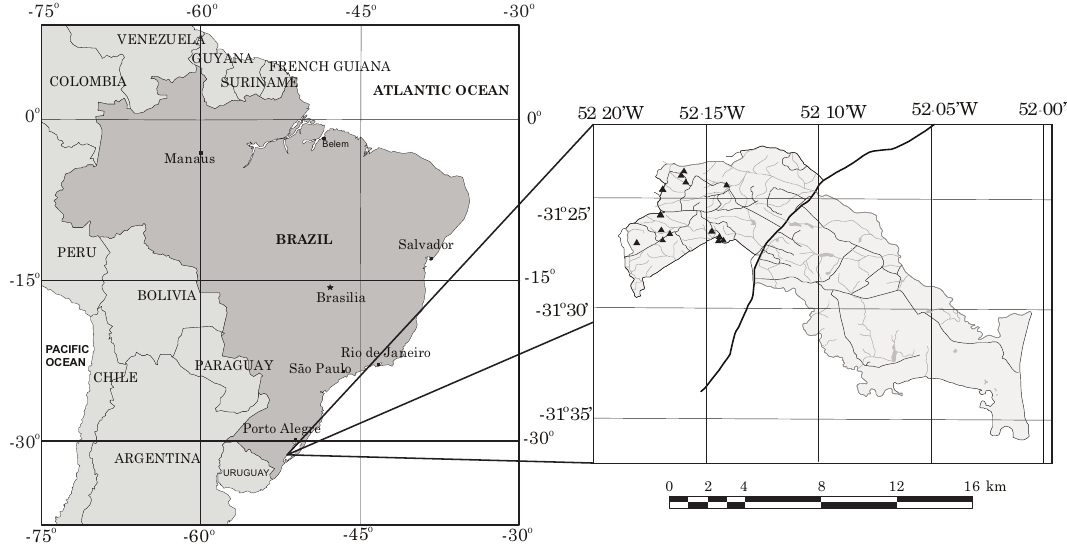
Figure 1. Location of the 14 strawberry fields under study in the county of Turuçu (RS). Adapted from Bamberg et al.